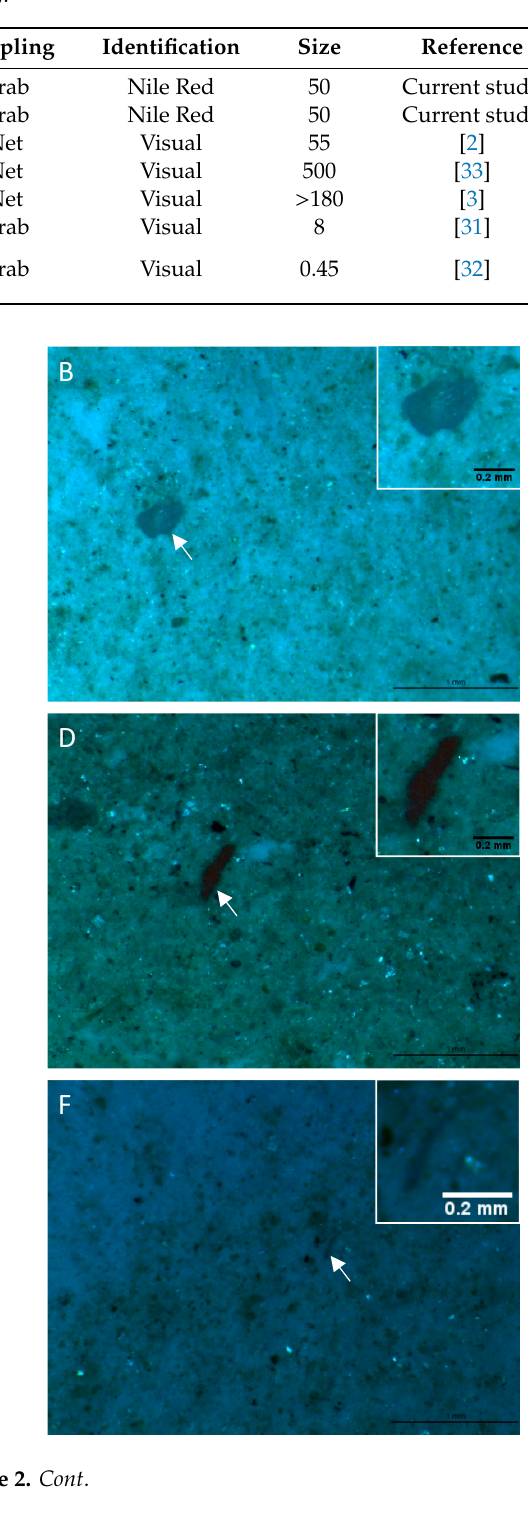
Table 1. Concentration of microplastics (MP m − 3 ) in several locations using different methods for sampling, identification, and minimum size (µm).